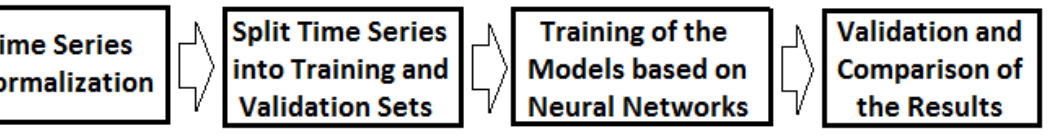
Figure 6. Methodology.